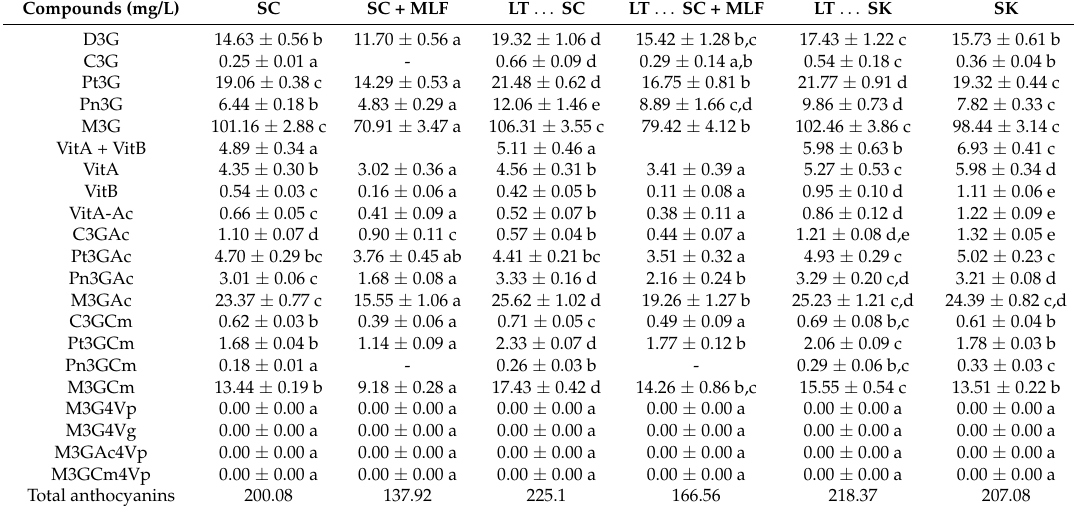
Table 3. Final analysis of anthocyanins from fermentations by S. cerevisiae 88 alone (SC), sequential fermentation with S. cerevisiae 88 and L. thermotolerans CONCERTO™ (LT . . . SC), sequential fermentation with S. pombe V2 and L. thermotolerans CONCERTO™ (LT . . . SK), Schizosaccharomyces pombe V2 alone (SK), and fermentations after malolactic fermentation with Oenococcus oeni 217 (+ MLF). Compounds (mg/L)